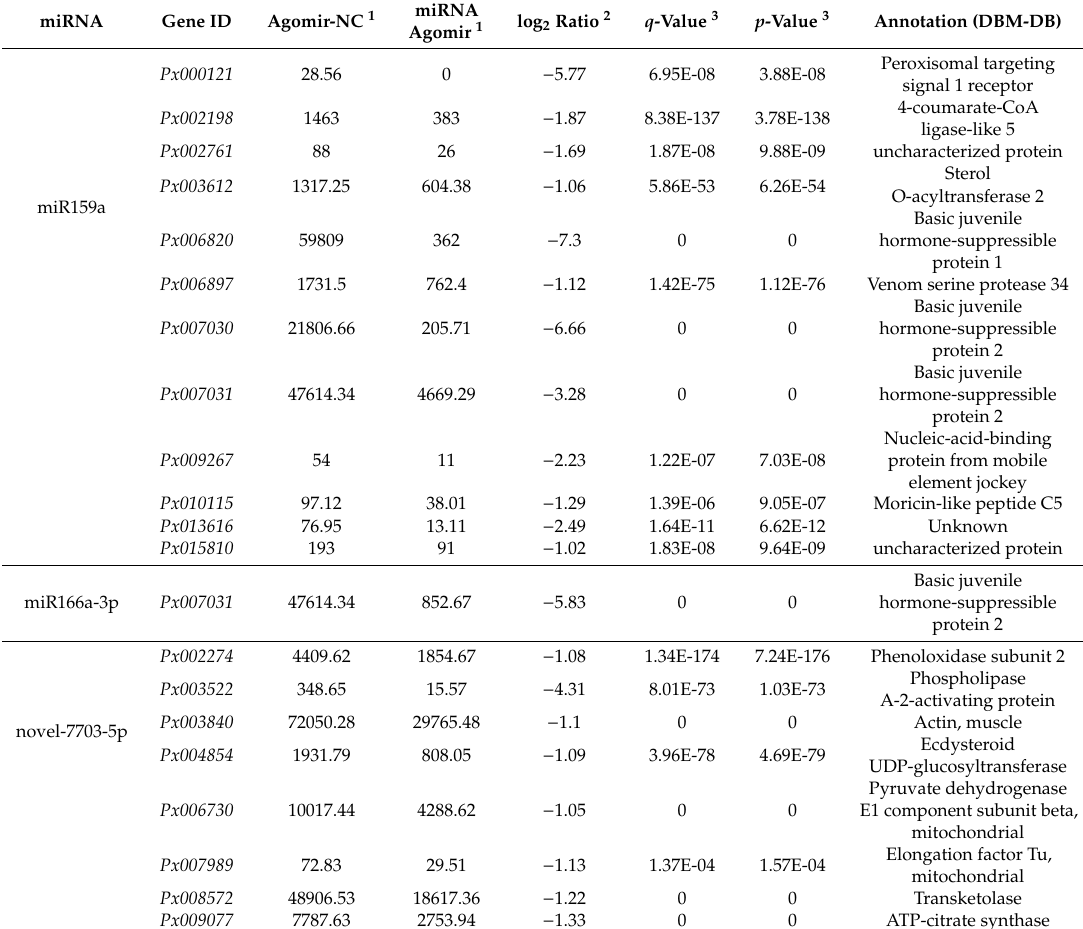
Table 2. Predicted target genes down-regulated in miRNA agomir treatments.